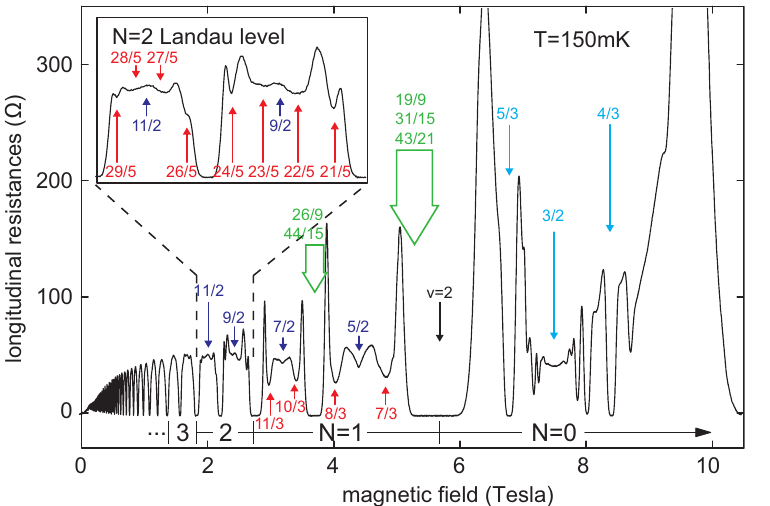
Figure 4. Visible in experiment [39] single-loop FQHE states for Landau index n = 1 i n = 2 ( N in the figure) (in GaAs)—indicated in red color; blue ones—4/3, 5/3 are three-loop FQHE in the lowest Landau level at n = 0; ν = 5/2,7/2,9/2,11/2 are paired states, but at 3/2 is the Hall metal; the green color marks a few FQHE from multi-loop series pushed toward band edges at n > 0 and obscured by IQHE- reentrant in the vicinity of integer fillings